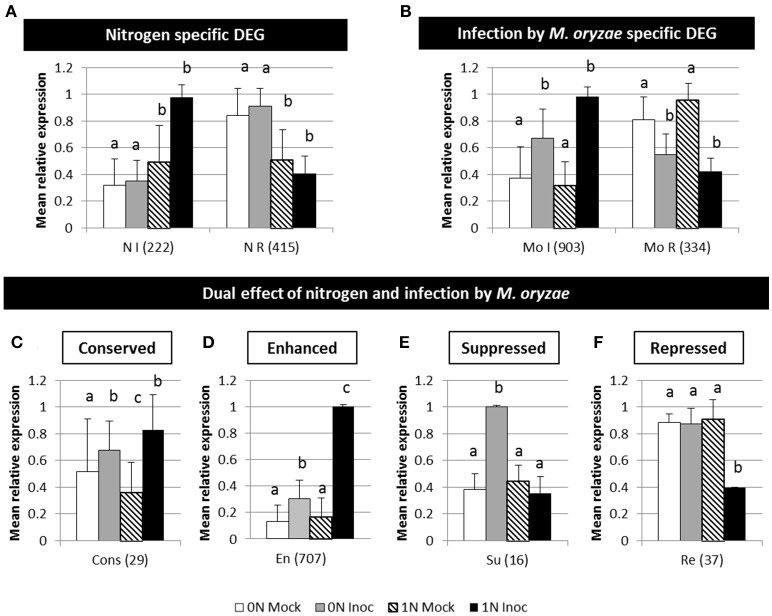
Major type of patterns of rice differentially expressed genes during infection under different nitrogen fertilization. (A) Nitrogen specific genes: genes differentially expressed between 0N and 1N treatment but not differentially expressed during infection. (B) Gene expression profile specific of infection by M. oryzae. (C) Gene expression level conserved between 0N and 1N during infection. (D) Enhanced response to inoculation in the 1N condition. (E) Suppression of response to inoculation in 1N condition. (F) Repression by infection only in the 1N condition. Four different conditions were compared with Deseq2 analysis: 0N fertilized and mock inoculated (white), 0N fertilized and Guy11 inoculated (light gray), 1N fertilized and mock inoculated (black dash) and 1N fertilized and Guy11 inoculated (black). The six global patterns indicated here represent the mean and sd expression values of the considered group of genes, as identified by analysis of the p-value obtained for each comparison with Deseq2. For each histogram, a given letter identifies similar values. The values between parentheses represent the number of genes in each category. I, induced; R, repressed; N, nitrogen; Mo, Magnaporthe oryzae; Cons, conserved; En, enhanced; Su, suppressed; Re, repressed. Kasalath plants were fertilized with low (0N) and high (1N) nitrogen fertilization 1 day before inoculation. Plants were inoculated with the Guy11 isolate or a mock solution. RNA were extracted 2 days after infection and analyzed using RNA-seq (see Section Materials and Methods).